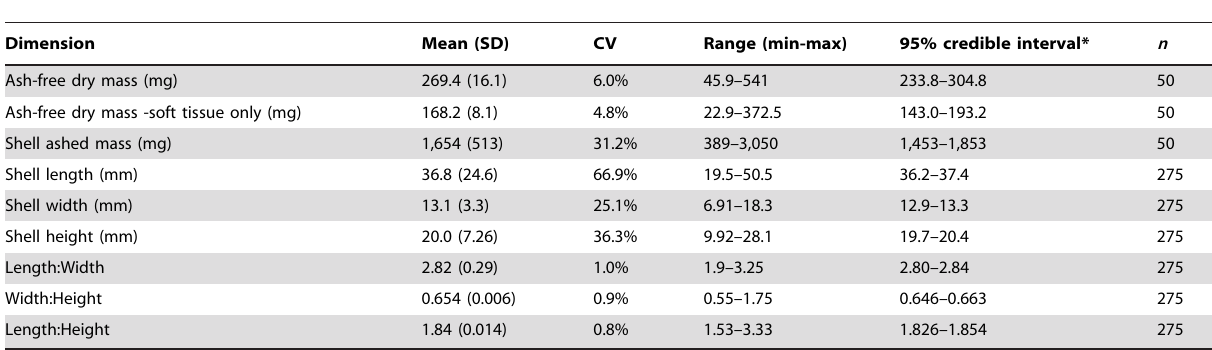
Table 1. Size and mass of 275 Lampsilis siliquoidea (fatmucket) mussels artificially propagated and reared to age 2.